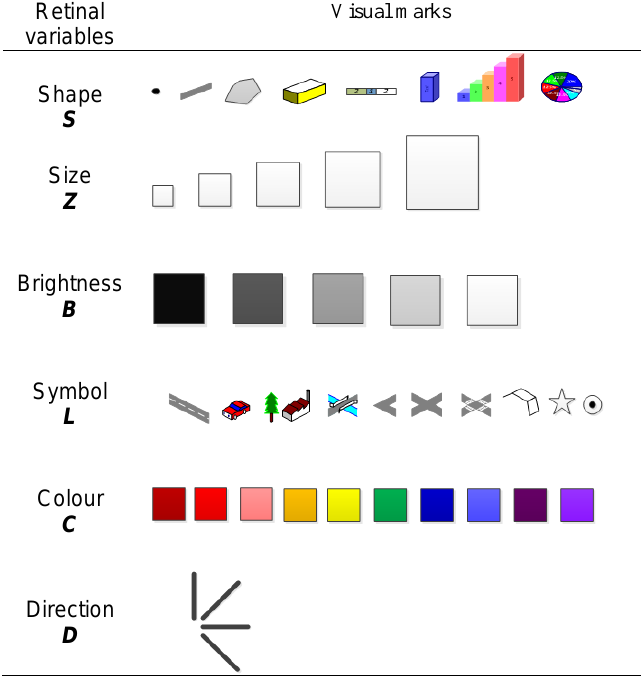
Table 1. Retinal variables (according to Bertin [3,